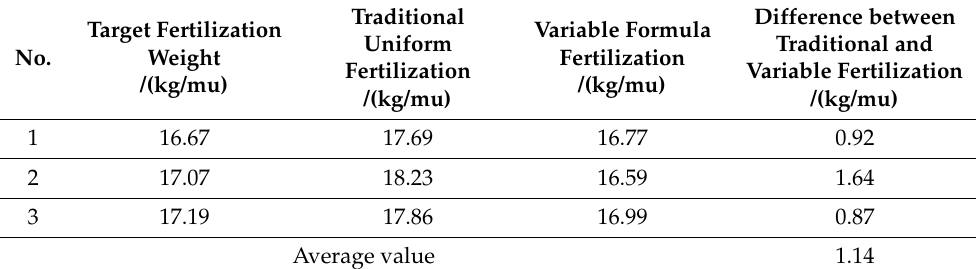
Table 5. Test to verify measurement